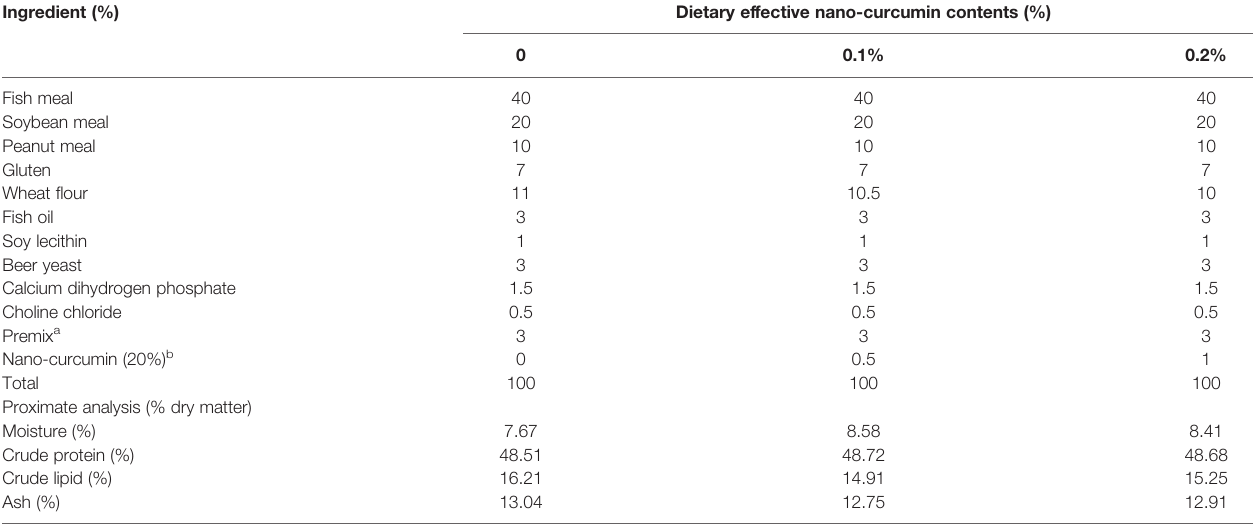
TABLE 1 | Ingredients and proximate composition of the experimental diets. Ingredient (%) Dietary effective nano-curcumin contents